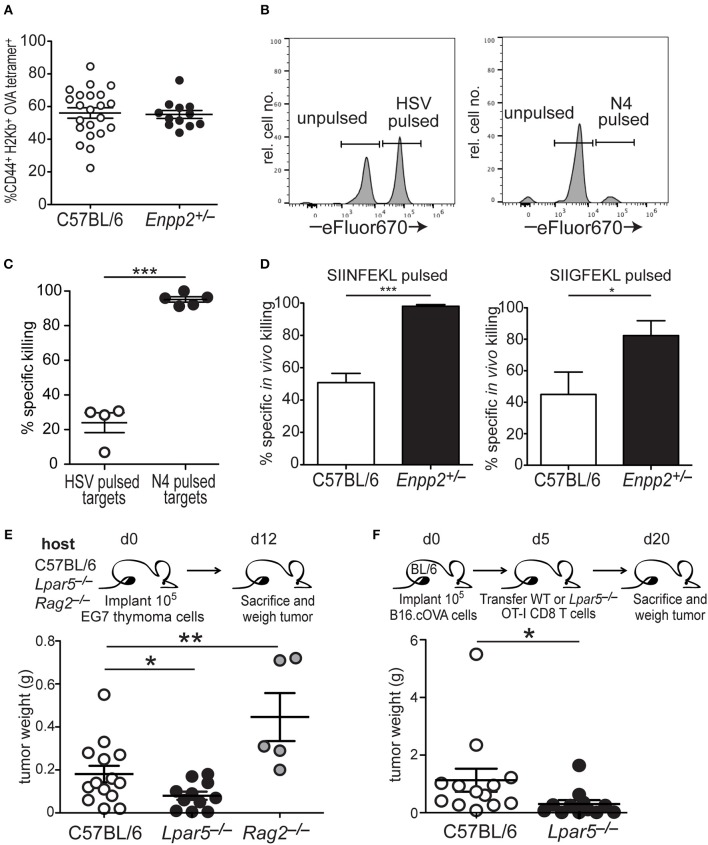
LPA signaling via LPA5 suppresses in vivo antigen-specific CD8 T cell cytotoxicity. (A) Frequency of OVA-reactive endogenous CD8 T cells (CD44+H2-Kb-OVA tetramer+) in the spleens of C57BL/6 (open) or Enpp2+/− (filled) mice 4 days after immunization with pI:C, anti-CD40 and OVA. (B) Panels show histograms of representative target cell killing 1 day after the transfer of target cells pulsed either with an irrelevant (HSV; left panel) or antigen-specific (OVA; right panel) peptide. Peptide-pulsed splenocytes were stained with a relatively high concentration of eFluor670 whereas unpulsed splenocytes are stained with a relatively low eFluor670 concentration. (C) Percent specific killing of irrelevant (HSV) peptide-pulsed splenocytes (open circles) and SIINFEKL (N4) peptide-pulsed splenocytes (filled circles) by endogenous SIINFEKL-specific CD8 T cells 4 days after immunization with anti-CD40, pI:C, and OVA. Percent specific killing was calculated as: (1– experimental ratio/pre-transfer ratio) × 100 and where the Ratio = %peptide–pulsed cells/% non-pulsed cells. ***p < 0.0005 using a one-tailed paired Student's t-test. (D) Percent antigen-specific killing of SIINFEKL-pulsed (left) or SIIGFEKL-pulsed (right) target cells 24 h after i.v. transfer of target cells into immunized mice. Data are cumulative of two experiments with 4–10 mice per group. *p < 0.05; ***p < 0.0005 using a one-tailed paired Student's t-test. (E) EG7 lymphoma cells were implanted into either WT, Lpar5−/−, or Rag2−/− hosts for 12 days after which they were isolated and weighed. Data are cumulative of 3 independent experiments reflecting tumors recovered from 13 WT hosts, 11 Lpar5−/− hosts, and 5 Rag2−/− hosts. *p < 0.05; **p < 0.005 using a one-tailed paired Student's t-test. (F) B16.cOVA tumor cells were implanted into the flank of B6 mice for 5 days after which either wild type or Lpar5−/− OT-I CD8 T cells were transferred i.v. into tumor bearing hosts. Fifteen days later recipients were sacrificed and tumors resected and weighed. *p < 0.05; data represents two independent experiments with 12–13 mice per group.